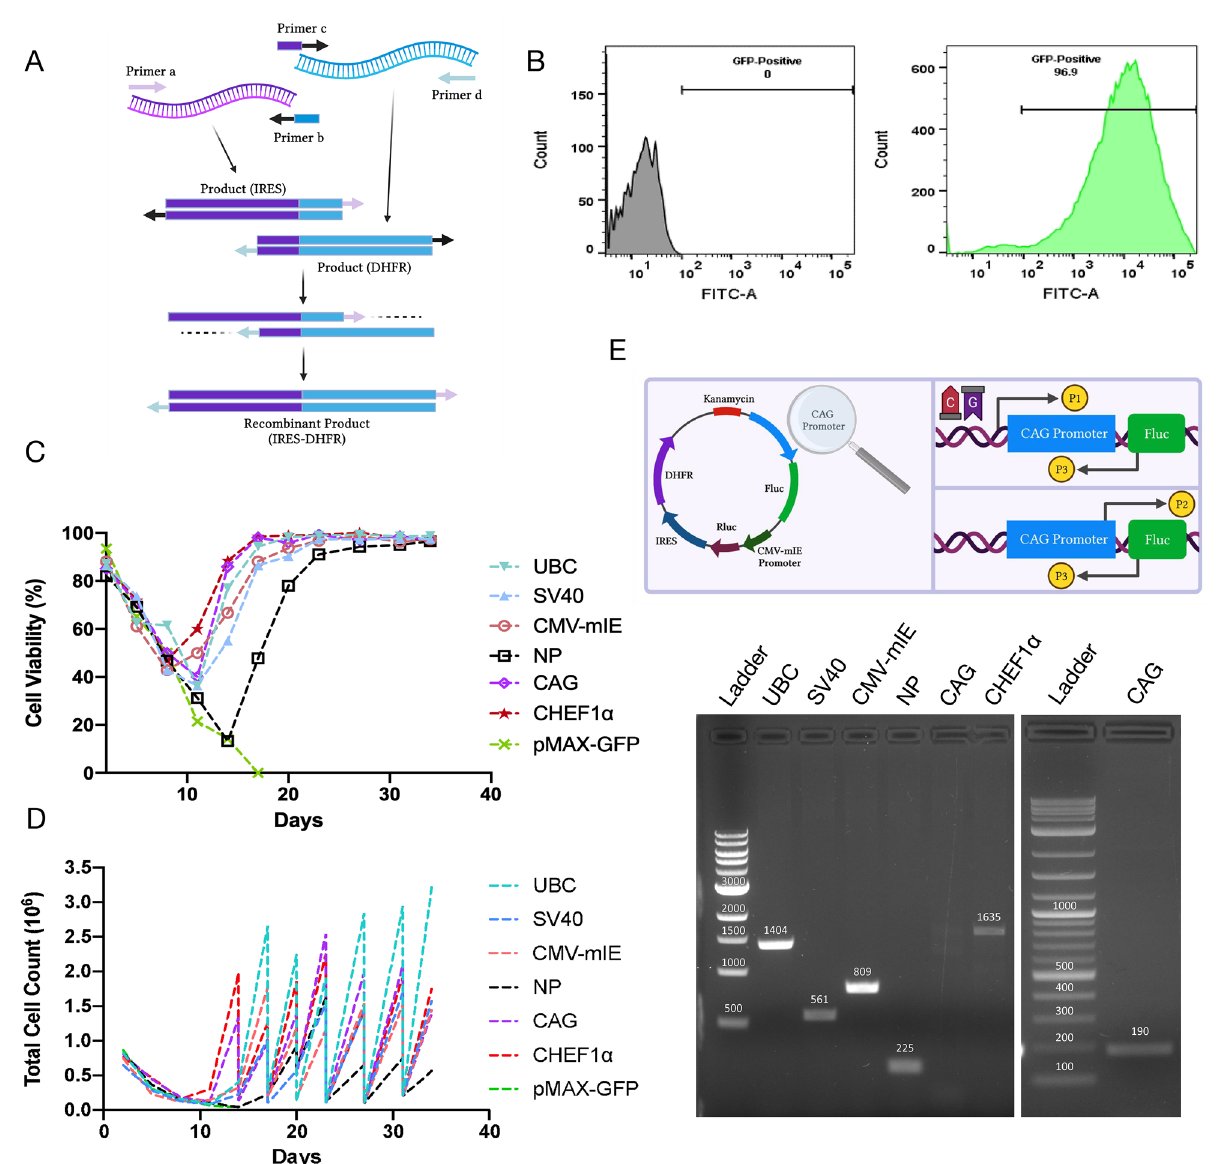
Figure 5. Development and validation of stably transfected polyclonal CHO-DG44 pools. ( A ) Schematic representation of IRES-DHFR cassette cloning using the overlapping PCR method. ( B ) Flow cytometry analysis of electroporated cells after 24 h of nucleofection. pMax-GFP vector was utilized as a transfection efficiency control. GFP positive cell count was detected as 96.9% (on the right). The flow cytometry result on the left indicates untransfected control with 0% GFP positive CHO-DG44 suspension cells. ( C ) Cell viability and ( D ) total cell count percentage during DHFR-based auxotrophic selection. In brief, cells were harvested in HT deprived CD OptiCHO selection media and Trypan blue exclusion-based counting was performed every two to three days. Cells were subcultured at 100.000–200.000 cells/ml. Taking into consideration the growth rate of CHO-DG44 pools, the cells were transferred from multiwell plates to orbital shake flasks. ( E ) The validation of genome integration was performed via conventional non-quantitative PCR using primer sets provided in Table 3. For the CAG promoter, the primer set was altered from P1–P3 pair to P2–P3 that amplifies a shorter fragment with lower GC content (see schematic). Specifically, while P3 reverse primer binds to a region at the 5’ end of the Fluc gene, P2 forward primer targets a region close to the 3’ end of the CAG promoter, that is further verified by Sanger sequencing (data not shown). Note that two different DNA ladders (1 kb DNA ladder—left and 1 kb plus DNA ladder—right) were used in the agarose gel experiments. Expected amplicon and relevant DNA ladder band sizes are highlighted on the agarose gel images. The schematics in ( A ) and ( E ) are created with